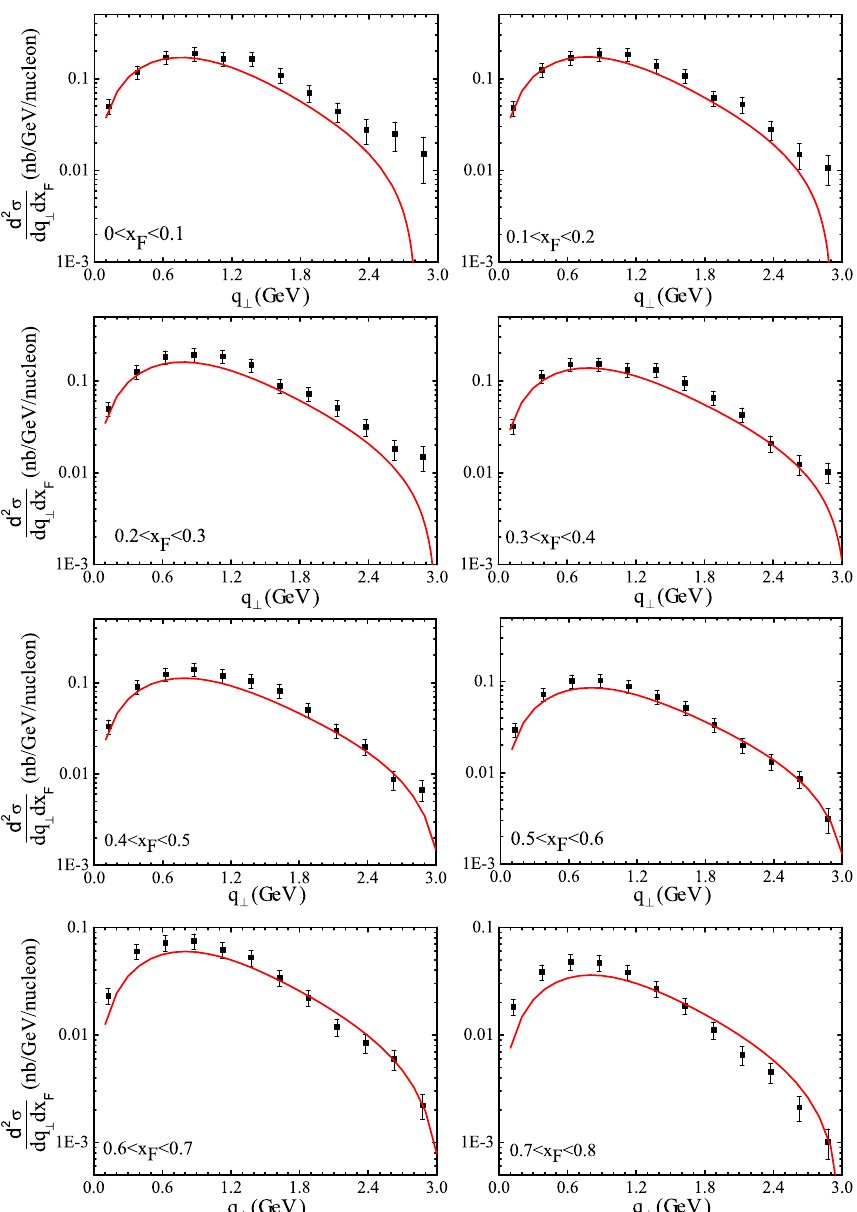
Figure 1 . The (cid:12)tted cross section (solid line) of pion-nucleon Drell-Yan as functions of q ? , com- pared with the E615 data (full squre), for di(cid:11)erent x F bins in the range 0 < x F < 0 : 8. The error bars shown here include the statistical error and the 16% systematic